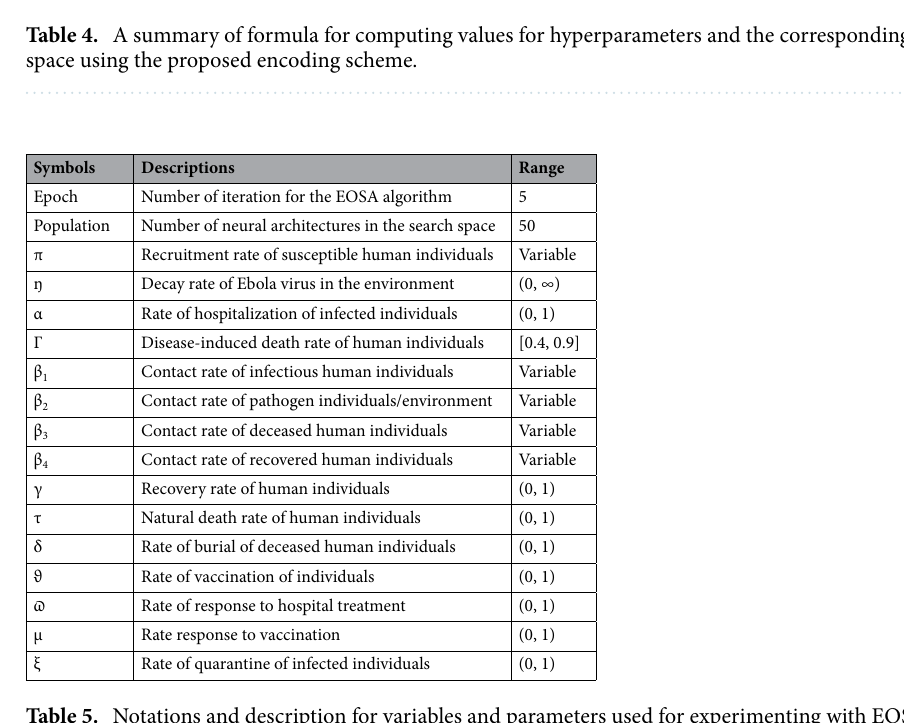
Table 5. Notations and description for variables and parameters used for experimenting with EOSA optimization algorithm.